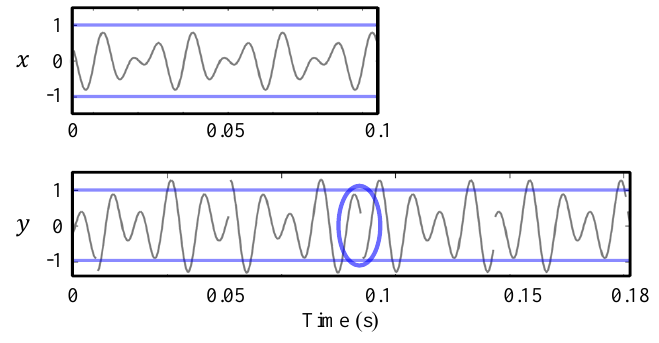
Figure 2. Typical artifacts that occur when choosing the synthesis frames y m to be equal to the analysis frames x m . The input signal x is stretched by a factor of α = 1.8. The output signal y shows discontinuities (blue oval) and amplitude fluctuations (indicated by blue